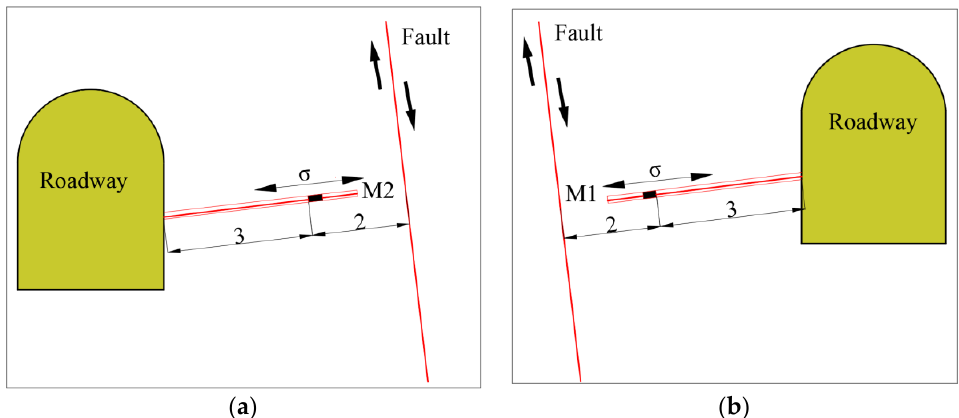
Figure 5. Schematic diagram of the mark line observation method.